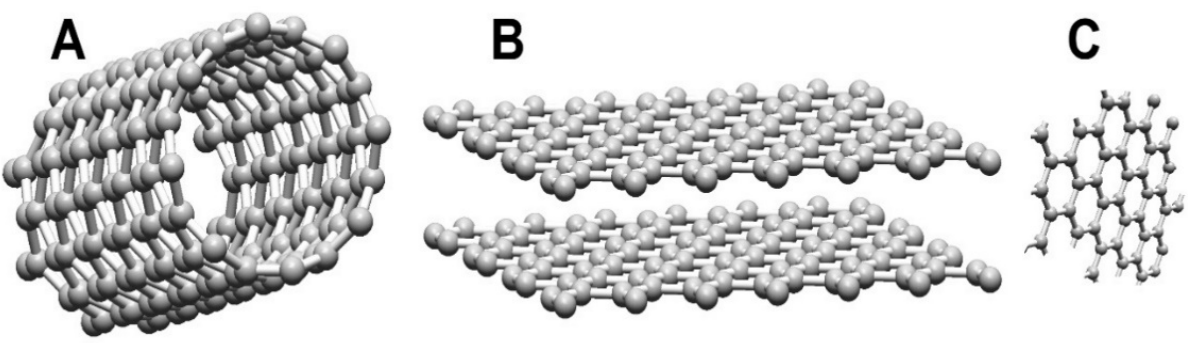
Figure 1. Carbon structures: ( A ) nanotubes, ( B ) graphene and ( C ) quantum dots.